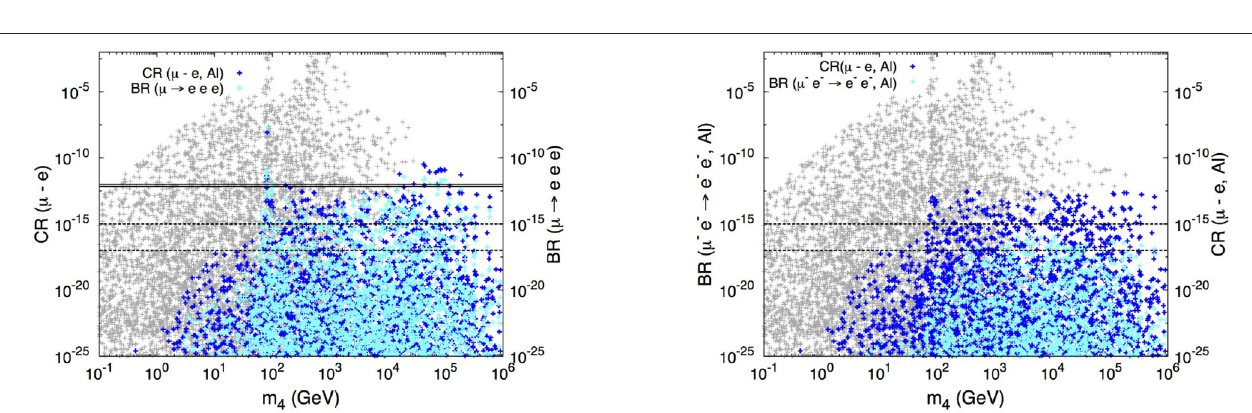
e , Al) and BR( µ eee ) as a function of m 4 ; the former is displayed in dark blue (left axis), while the latter is depicted − → e , Au) [29] ( µ eee decays [27]), while dashed lines − → e , Al) [31, 33, 34]. On the (right) , BR( µ − e − e − e − ) (cyan, left axis) and CR( µ e , Al) (dark blue, right axis) as a function − → −